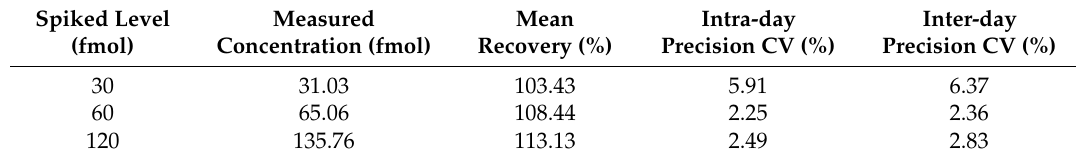
Table 1. Recoveries of the peptide spiked in defatted soybean seed samples ( n = 5). Spiked